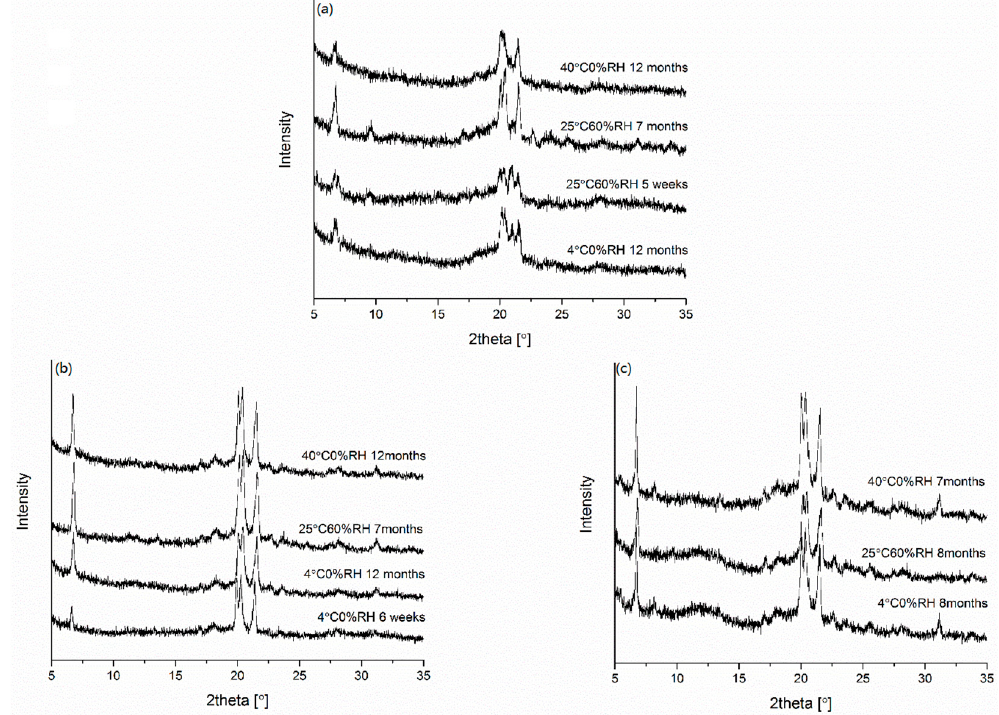
Figure 6. X-ray diffractograms of the spray-dried powders after storage under different conditions: ( a ) SVS-LYS spay dried from 5% SLS; ( b ) SVS spray-dried from 5% SLS; ( c ) SVS-LYS CM + SLS.